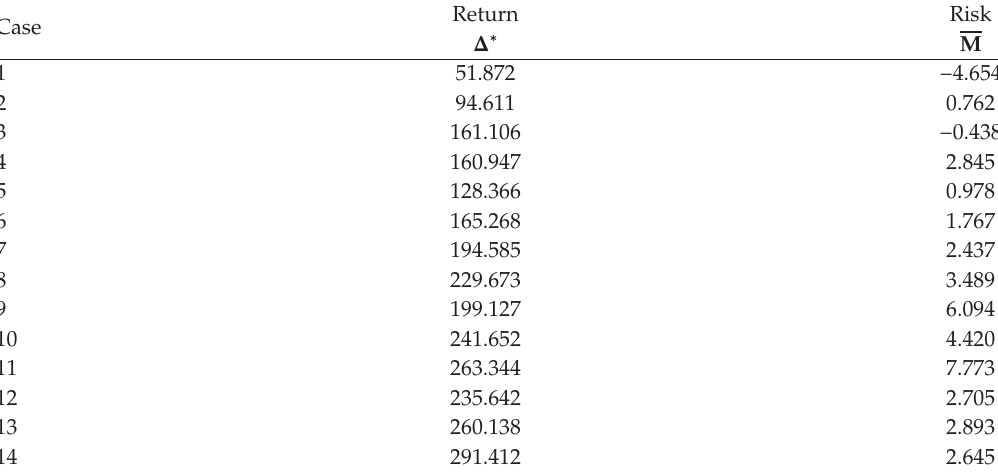
Table 2: Risk-return profile for return